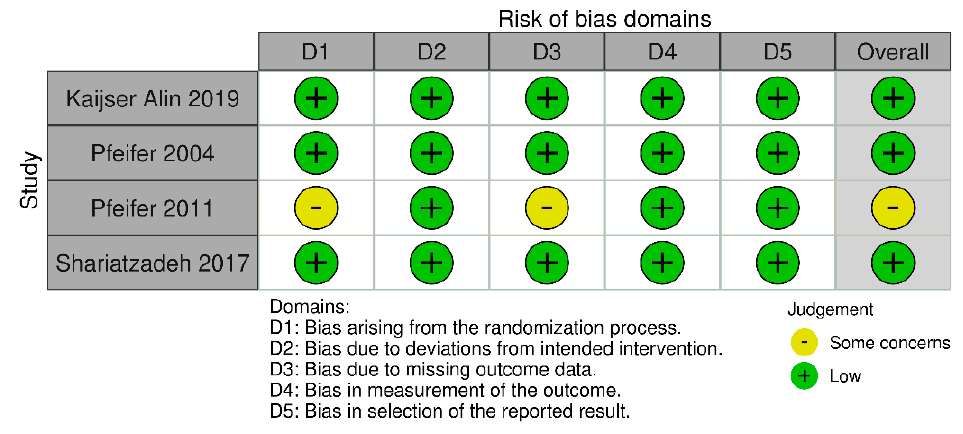
Figure 2. Risk of bias summary of the studies included.